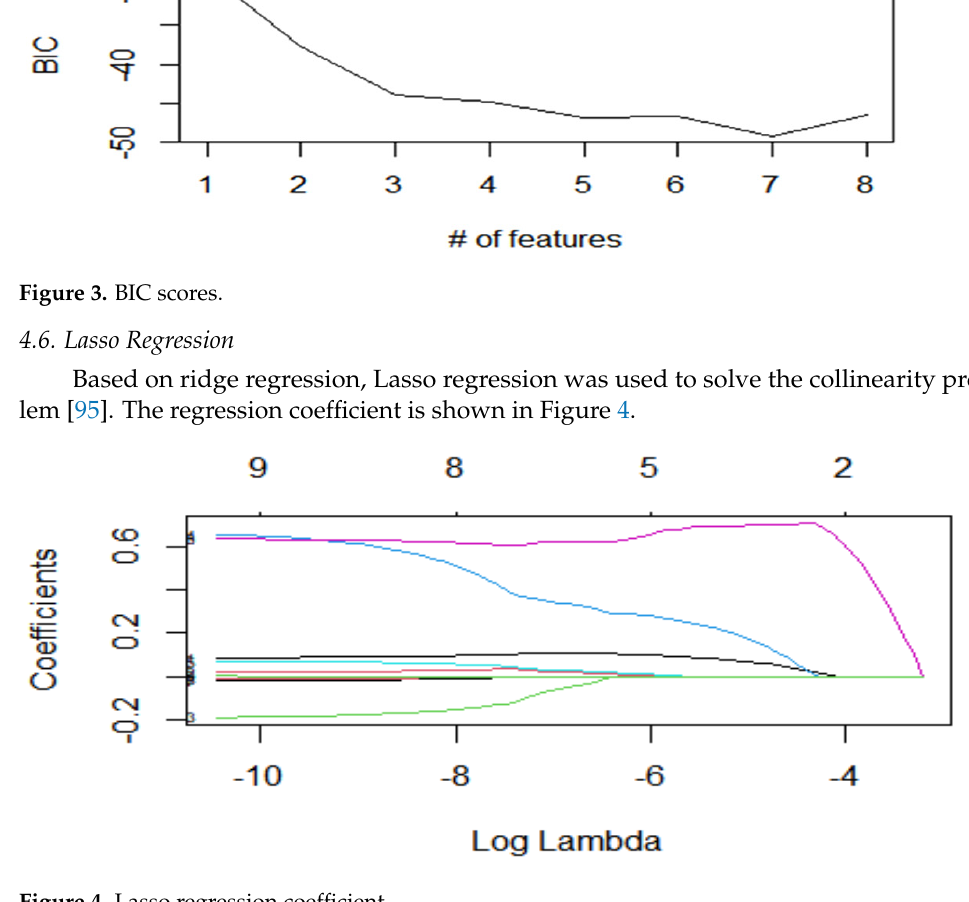
Figure 4. Lasso regression coefficient.